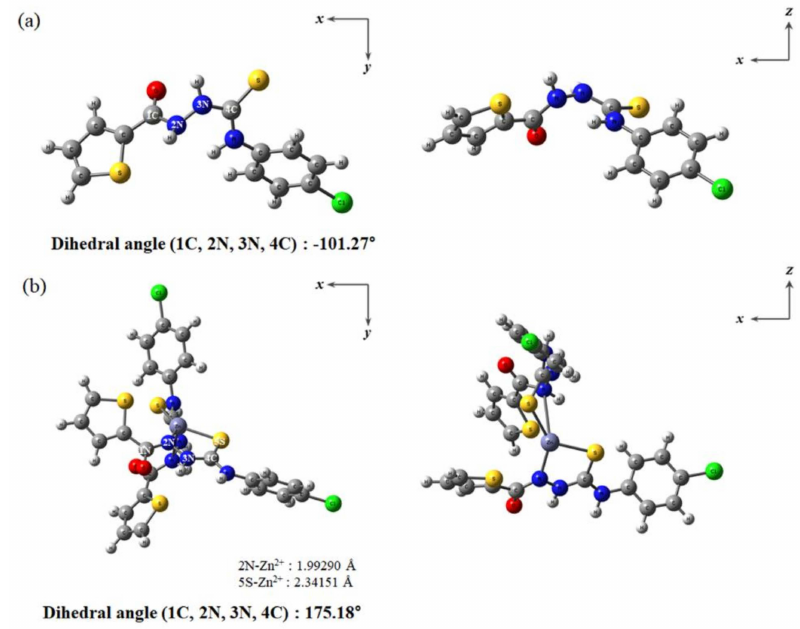
Figure 9. Energy-optimized patterns of ( a ) TCC and ( b ) Zn 2+ -2 · TCC